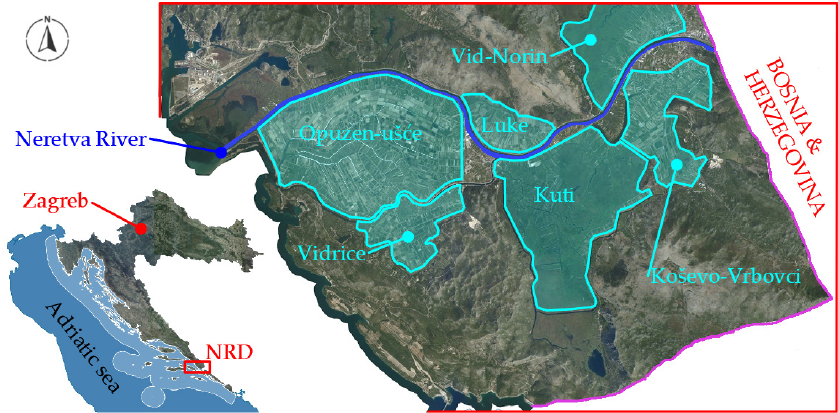
Figure 1. Overview map of the polders in the ameliorated area in the lower NRD (magenta—national border, cyan—individual polders).